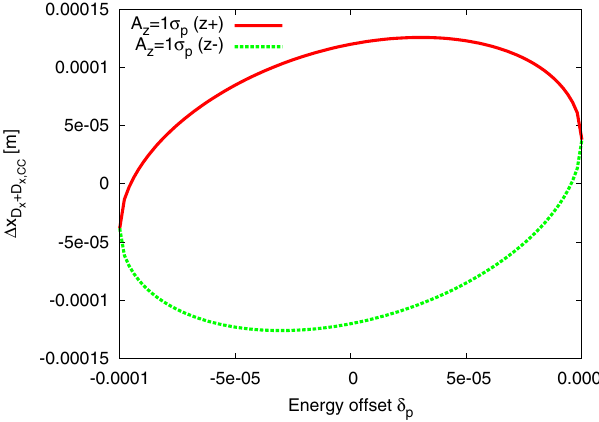
FIG. 10. (Color) Total orbit deviation versus energy offset (cid:2) p , at the primary collimator TCP.C6L7.B1, with both off-momentum dispersion and crab